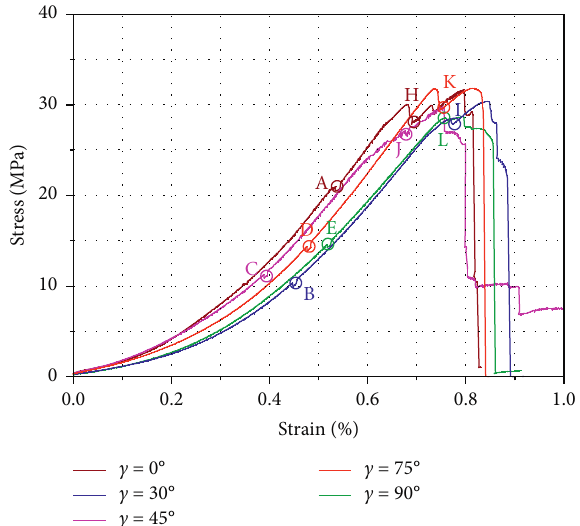
Figure 14: Stress-strain curves of sandy mudstone specimens for different angles between main and minor flaws ( c ).